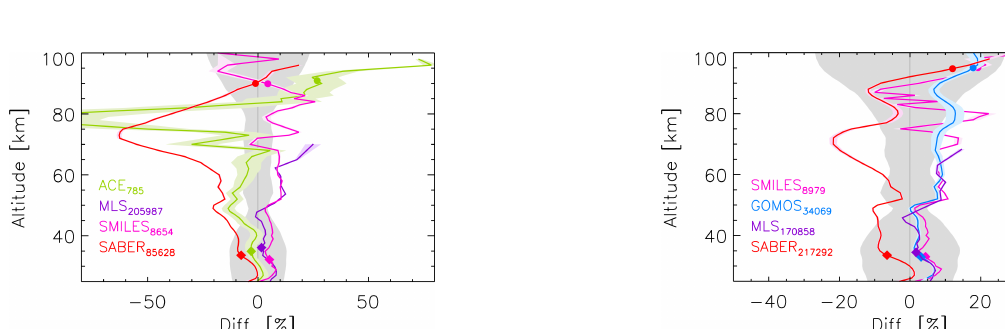
Figure 8. As Fig. 7 but for nighttime O 3 . Instrument colours are the same except that ACE-FTS is replaced by GOMOS (light blue).